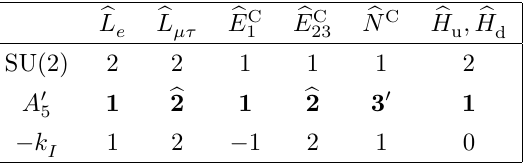
gauge symmetry and L